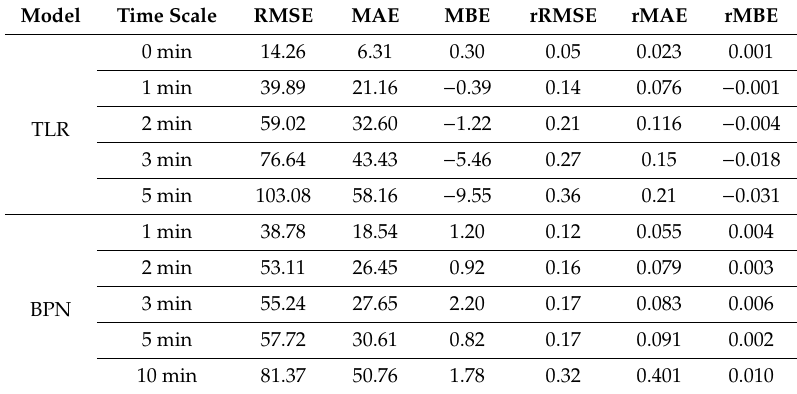
Table 5. The average forecasting error of 4 days comparison between the linear regression model and the neural network